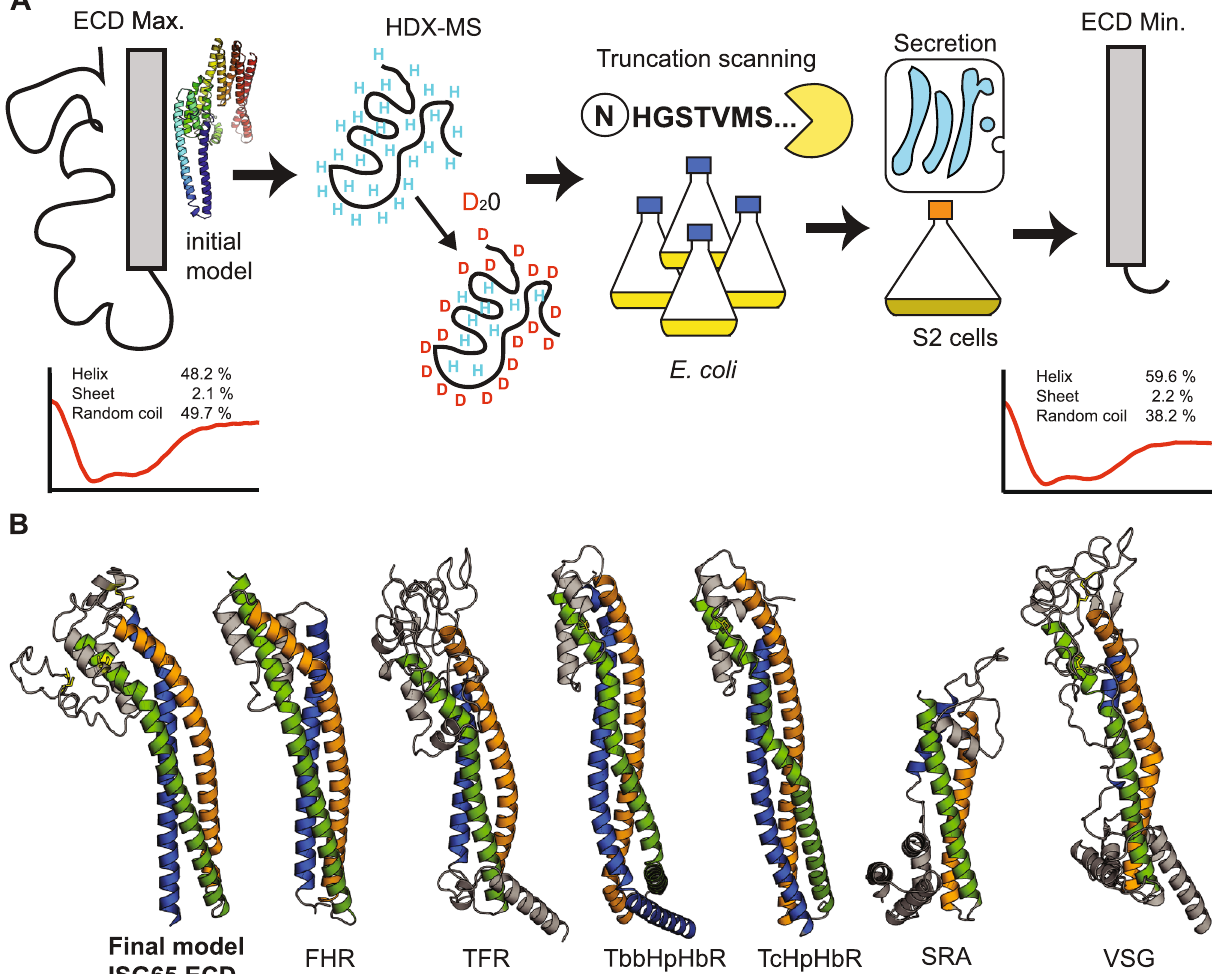
Figure 4. Flow-chart for rational construct design and guided model generation. ( A ) Simplified workflow for identification of a minimal construct that can be produced with high yields and purity. The longest ISG65 construct has a high random coil content (CD measurement, representative curve) which results in generation of an unrealistic model. The identified minimal construct of ISG65 has > 10% lower random coil content according to CD analysis (representative curve below). ( B ) Omission of the identified low-complexity region results in generation of a more realistic ISG65 model (far left). This model shows the same three-helix bundle that is canonical for structurally characterised, GPI-anchored trypanosoma surface proteins ([left to right] PDB IDs: 6XZ6, 6SOY, 4X0J, 4E40, 6ELU, 1VSG). ISG65 ECD, invariant surface glycoprotein 65 extracellular domain; FHR, factor H receptor; TFR, transferrin receptor; TbbHpHbR, Trypanosoma brucei brucei haptoglobin- hemoglobin receptor; Tc, Trypanosoma congolense ; SRA, serum-resistance associated protein; VSG, Variant surface